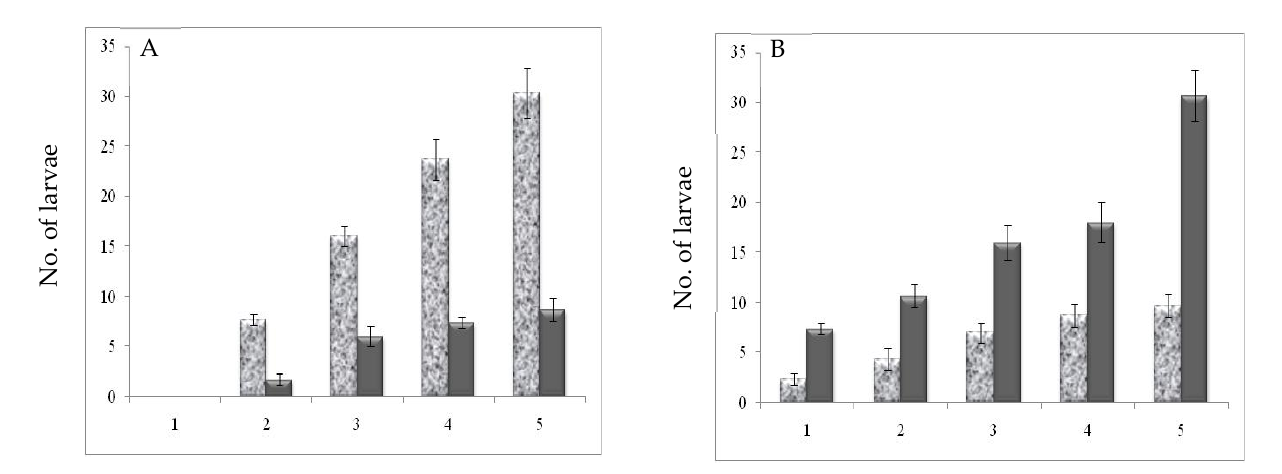
Figure 6. Bioassays of purified amylase inhibitor ( α AI.Mol) from Moringa oleifera against C. maculates insect larvae: pupation and mortality. ( A ) Rate of pupation of C. maculates insect larvae. The bioassay was studied by feeding C. maculatus larvae a diet containing purified α AI.Mol and compared to a